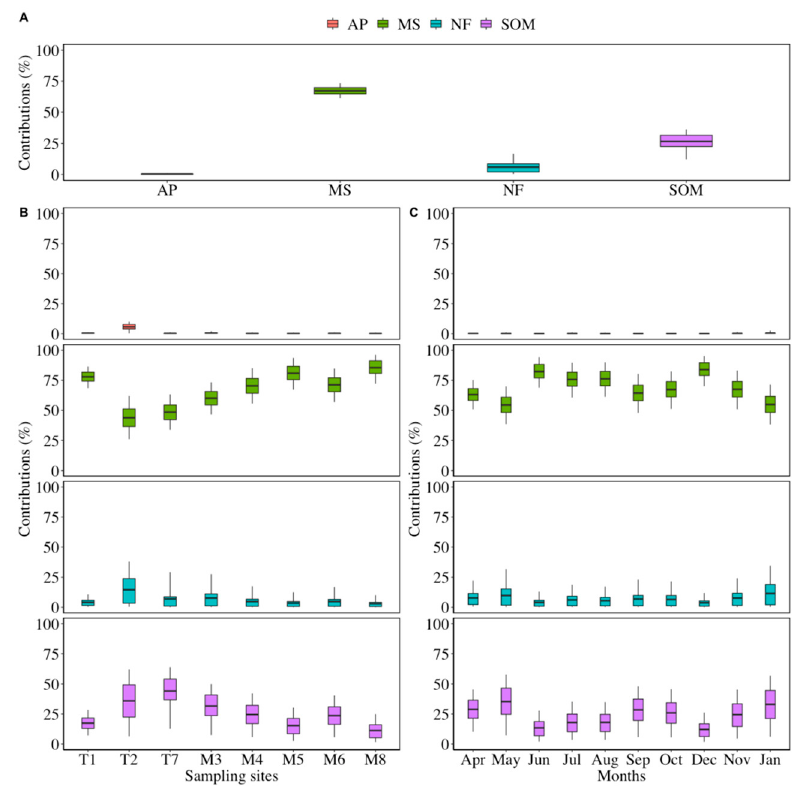
Figure 5. Fractional contributions of different sources to NO 3 − -N in Yuntaishan River basin. ( A ) Contributions from four main sources; ( B ) contributions in eight sampling sites; ( C ) contributions indifferent months. AP is atmospheric precipitation; MS is manure and sewage; NF is NH 4+ in fer- tilizer; SOM is nitrogen in soil organic matter. The data in the table show the mean contributions of different sources. The line within the box represents the mean values. The box spans the 0.25 and 0.75 quantiles, and the whiskers represent the 0.05 and 0.95 quantiles.